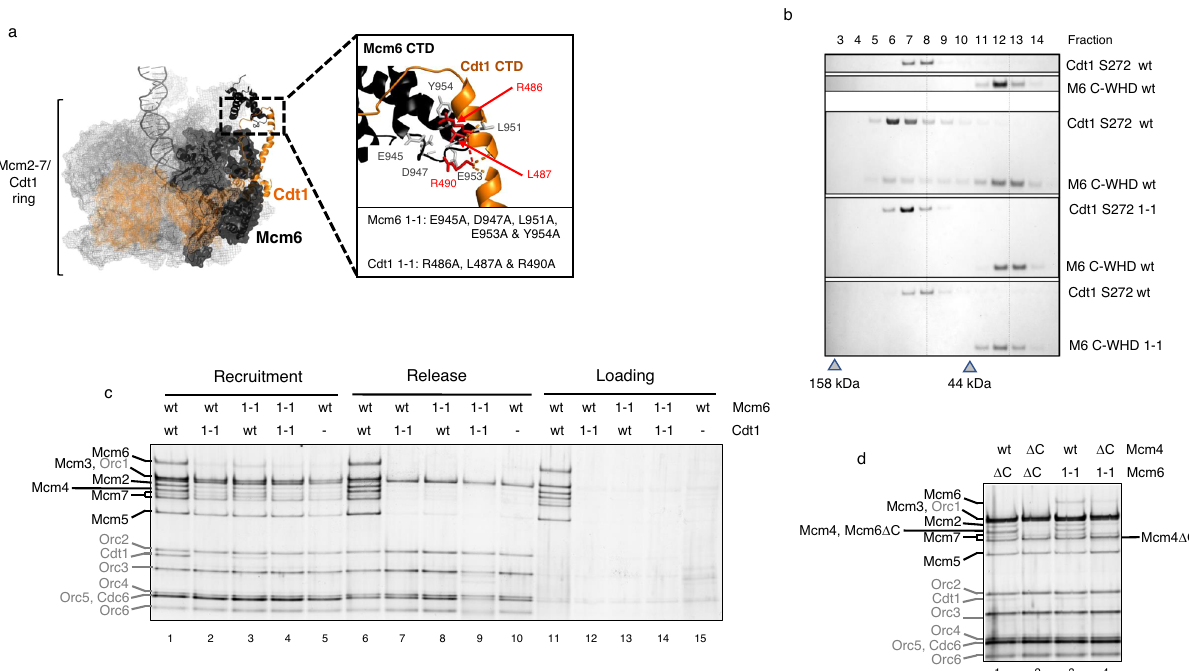
Fig. 4 Stabilization by Cdt1 requires interaction with Mcm6 C-WHD. Characterization of the Cdt1 and Mcm6 subunits which contain mutations that affect their interaction via their C-WHDs. These mutations were originally described by Liu et al. and here are named 1-1 mutations. a MCM-Cdt1 structure in the recruited OCCM complex (PDB: 5V8F). Mcm2-7 subunits are represented in grey mesh, except Mcm6 that is represented in black, while Cdt1 is represented in orange. Only the secondary structure of the C-WHDs of Mcm6 and Cdt1 is illustrated (in black and orange, respectively). The zoomed area shows the residues substituted in the 1-1 mutations. b The interaction between Cdt1 and Mcm6, either wt or 1-1 mutations, is assessed by gel fi ltration. To see a bigger shift in the gel fi ltration pro fi le, here we have used the Cdt1 S272 truncation (described in Fig. 3) and the Mcm6 C-WHD, either wt or 1-1 mutations. The peak fraction of two molecular weight markers is shown as a grey triangle (158 and 44 kDa). c PreRC assay of the MCM-Cdt1 complex, containing Mcm6 and Cdt1 wild type (wt) or 1-1 mutations (1-1). Omission of Cdt1 is used as negative control (lanes 5, 10 and 15). d Recruitment of MCM- Cdt1 containing an Mcm6 subunit with either 1-1 mutation (lanes 3 and 4) or a deletion of its C-WHD ( Δ C, lanes 1 and 2), in combination with Mcm4 wt or with its C-WHD deleted ( Δ C). Note that the Mcm4 Δ C and Mcm6 Δ C subunits are of reduced size and respectively migrate near Mcm7 and Mcm4 on